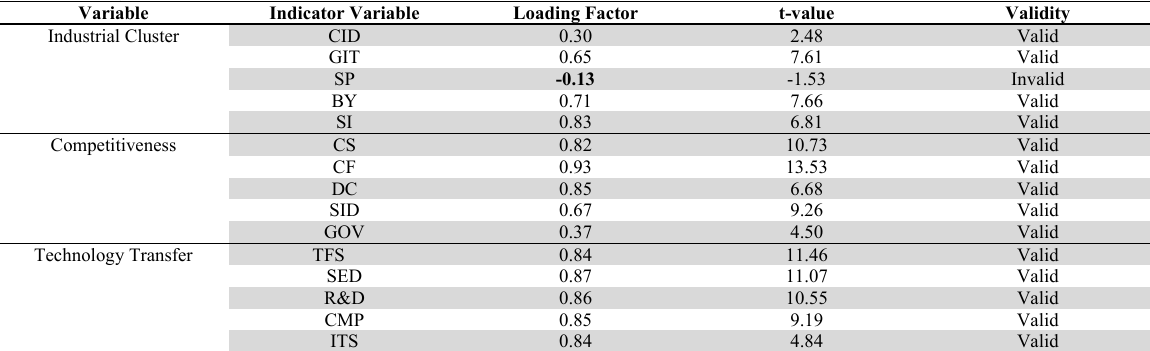
SEM Validity Test